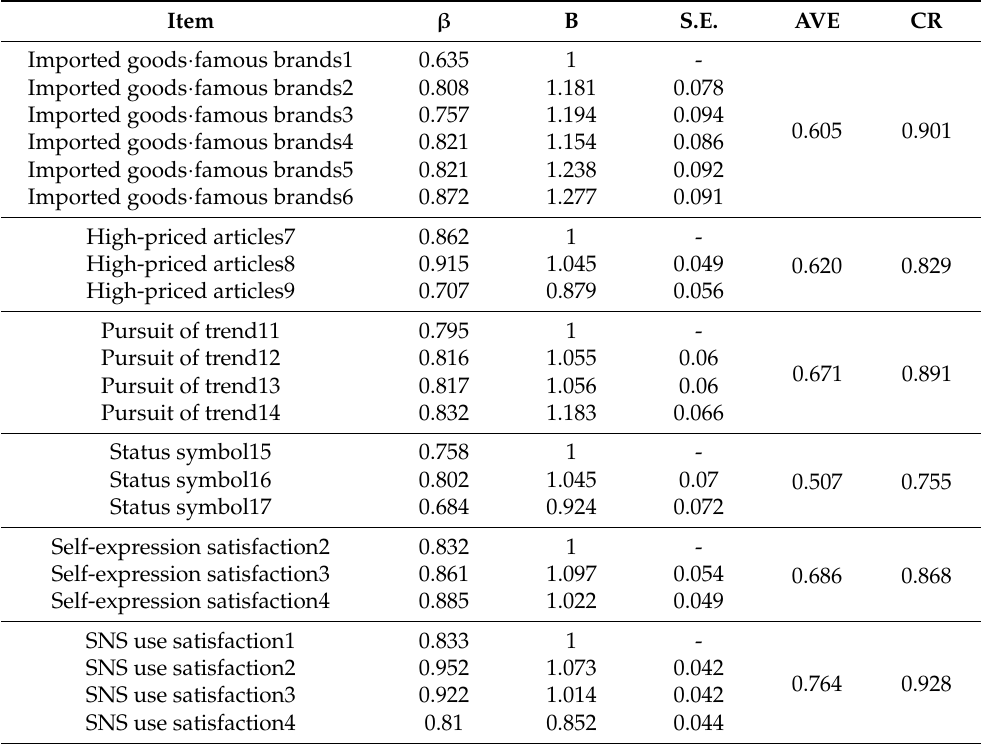
Table 3. Verification of